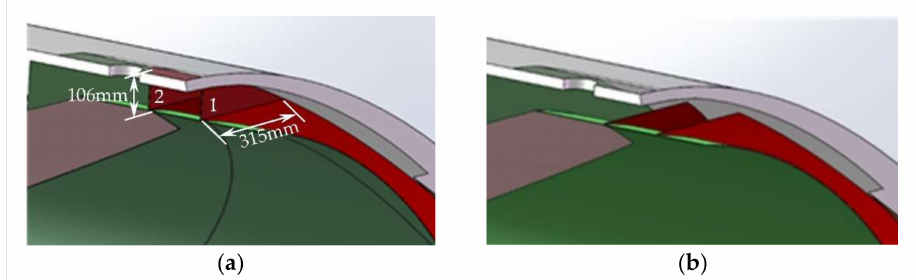
Figure 4. Optimized scheme 1: ( a ) before optimization; ( b ) after optimization.